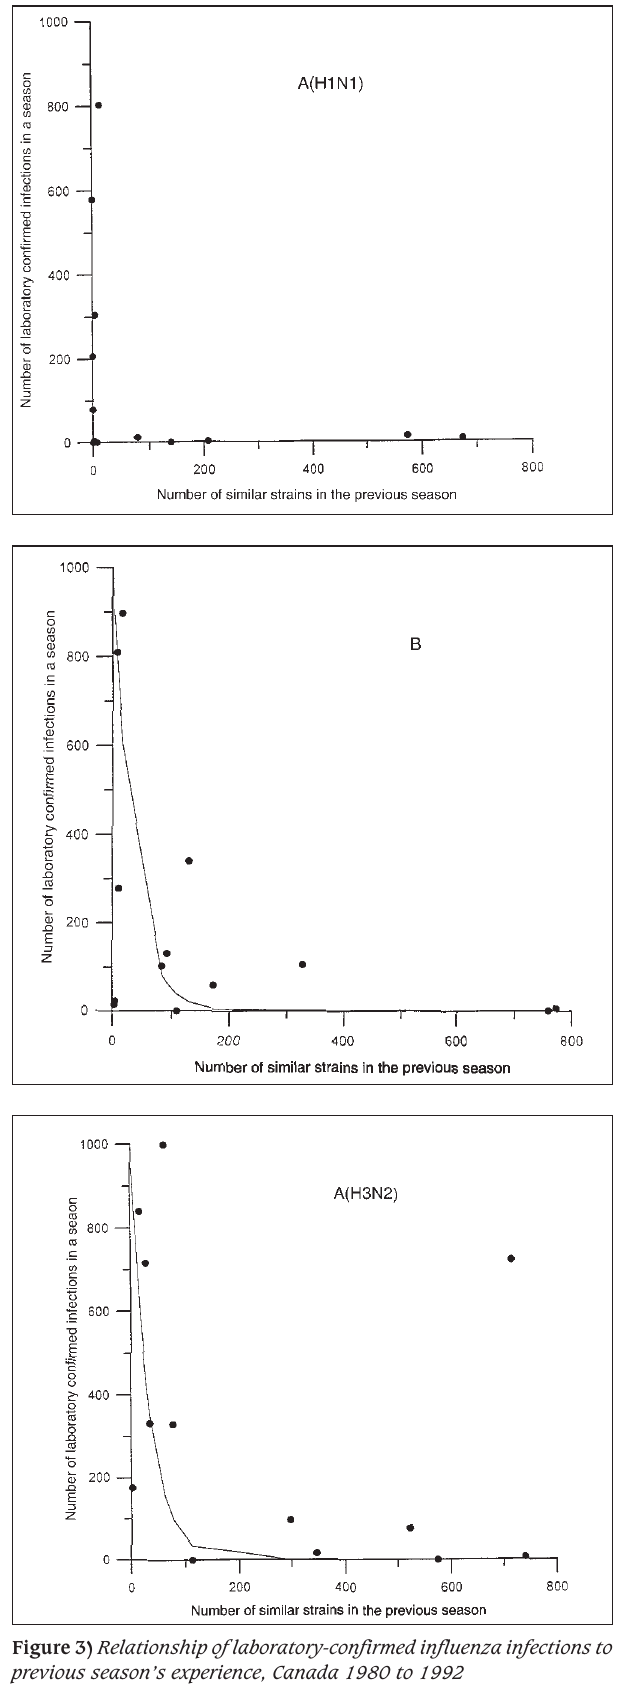
Figure 3) Relationship of laboratory-confirmed influenza infections